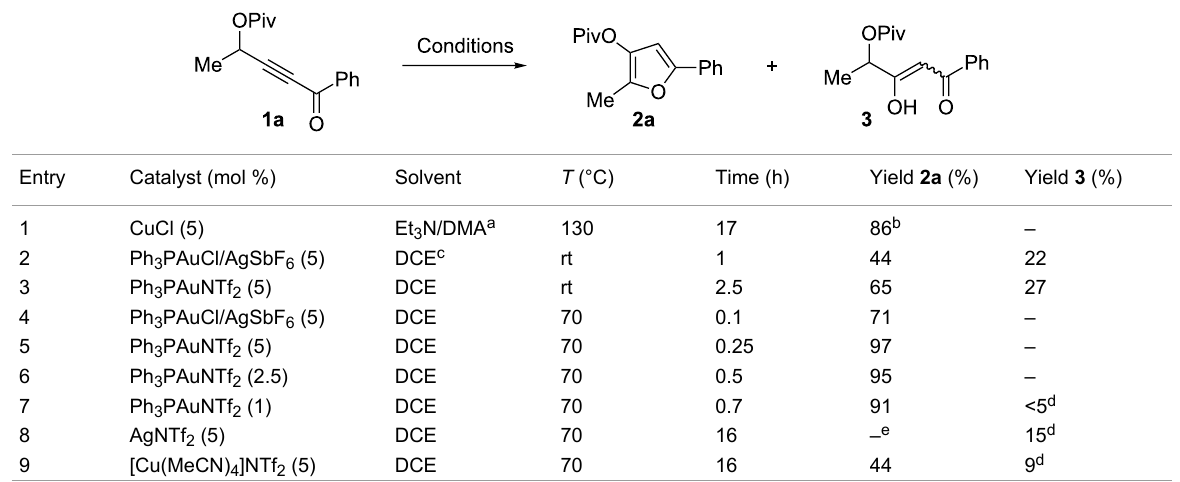
Table 1: Screening of the catalysts and the